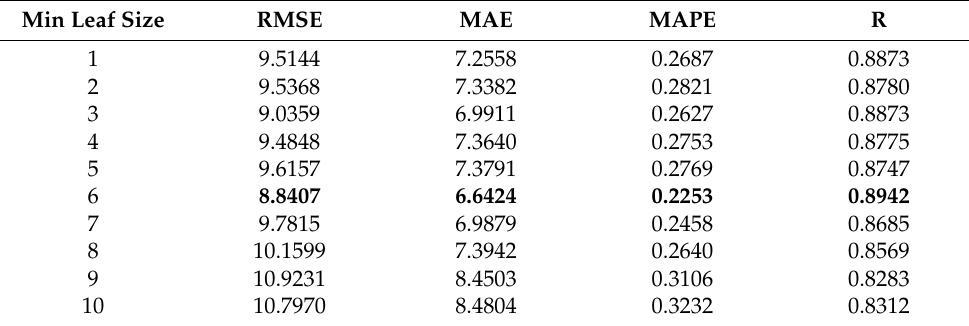
Table 5. Influence of minimum leaf size on regression tree (RT) model accuracy.